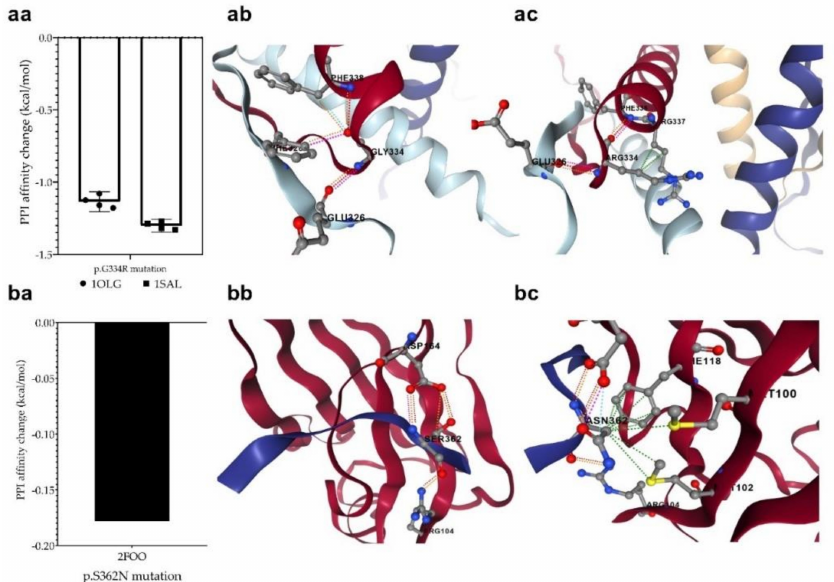
Figure 8. Changes in protein - protein interactions (PPI) upon p.G334R (aa) and p.S362N (ba) mu- tations . The 1OLG, 1SAL, and 2FOO are the PDB identifiers of the studied crystal structures (see Section 2). P.G334R mutation was supposed to affect interactions between the monomers of tetrameric p53, while p.S362N was considered to affect the interaction of p53 and USP7/HAUSP proteins. ( ab ): PPI between wild-type chains, ( ac ): PPI between wild-type and mutant chain, ( bb ): PPI between wild-type protein chain and USP7, ( bc ): PPI between mutant protein and USP7. The different dash dots between the residues indicate the type of interactions. Pink: clashes; light blue: van der Waals; red: hydrogen bond; yellow: ionic bond; green: hydrophobic; orange: polar.